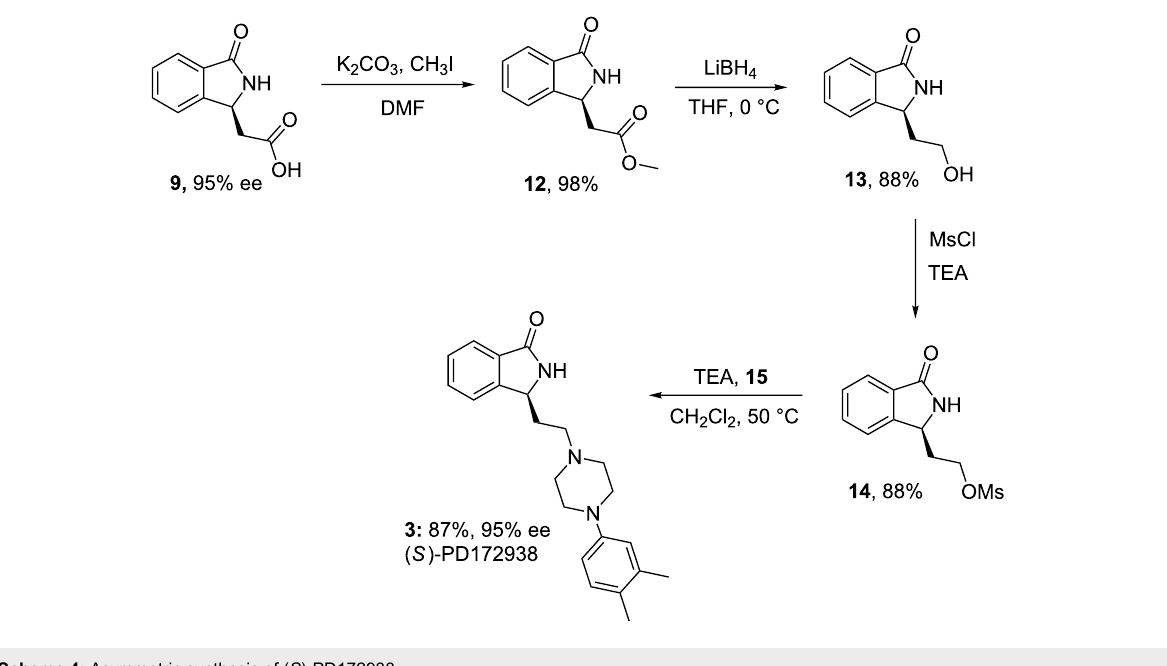
Scheme 4: Asymmetric synthesis of ( S